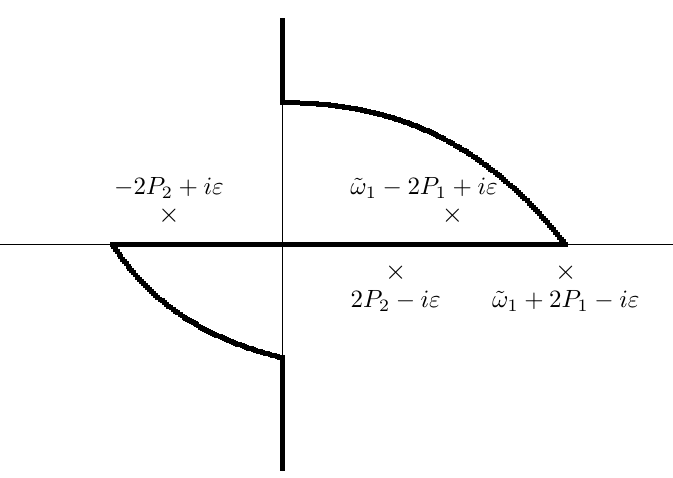
Figure 5 . The thick contour in this figure shows the choice of ˜ ω integration contour in (6.10). The × ’s mark the locations of the poles in the complex ˜ ω